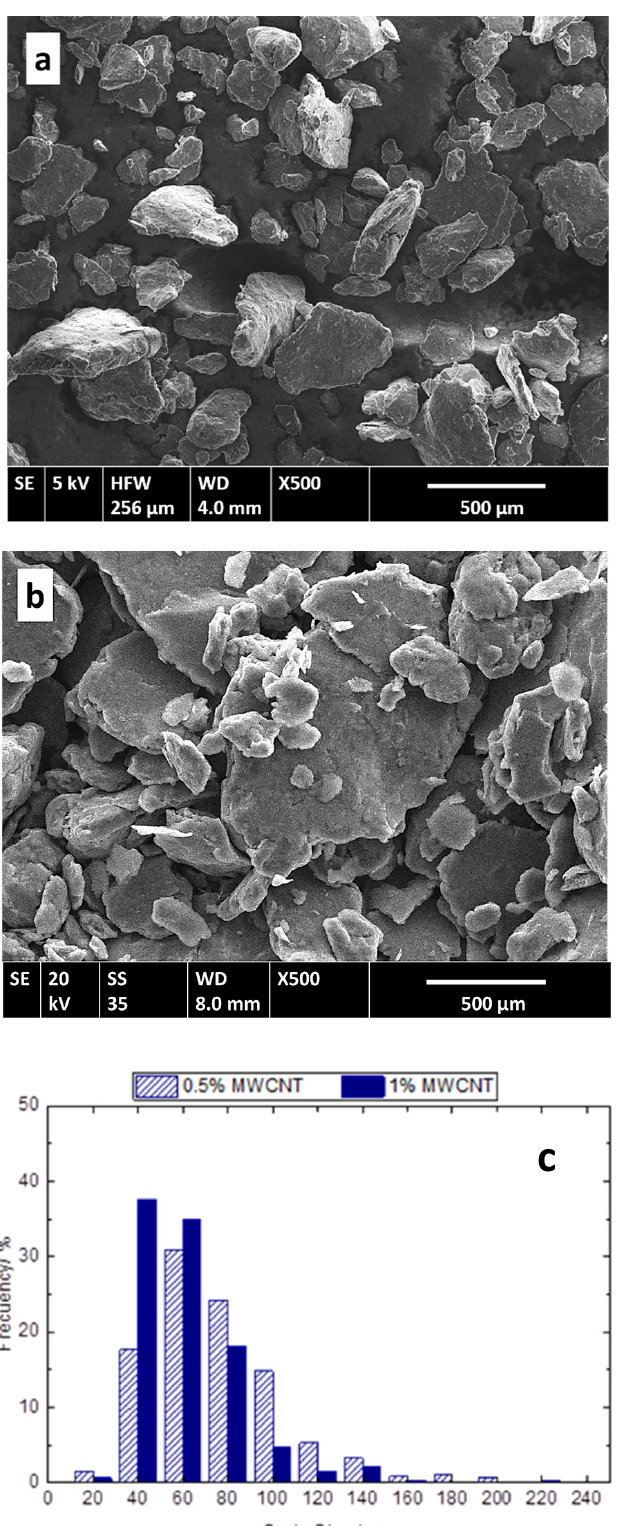
Figure 10. SEM micrographs of AA7075-MWCNT composites after completing the H + LEBM route (6 h total milling): ( a ) 1 wt.% MWCNTs; ( b ) 0.5 wt.% MWCNTs; ( c ) particle size distribution for both MWCNT content levels.